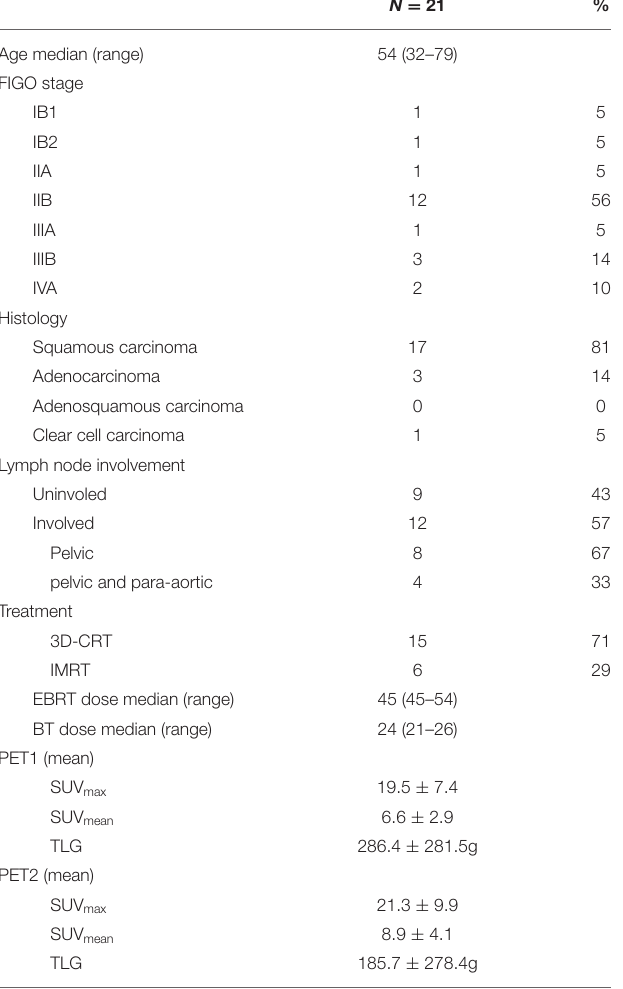
FIGO, international federation of gynecology and obstetrics; 3D-RT, three-dimensional conformal radiotherapy; IMRT, intensity-modulated photon radiotherapy; EBRT, external beam radiotherapy; BT, brachytherapy; SUV max , maximum standardized uptake value; SUV mean , mean standardized uptake value; TLG, total lesion glycolysis.